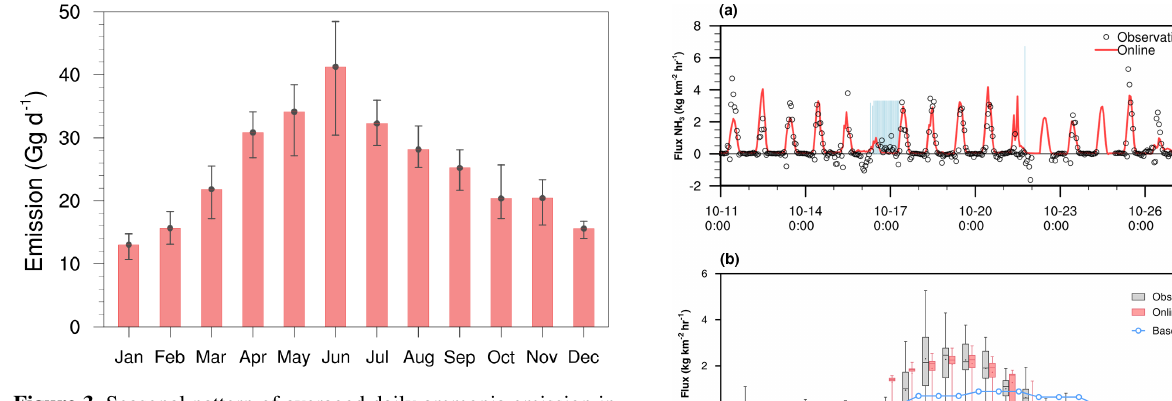
Figure 3. Seasonal pattern of averaged daily ammonia emission in eastern China (18–50 ◦ N, 95–131 ◦ E). The lower and upper points of vertical lines show the 10th and 90th percentiles, respectively.